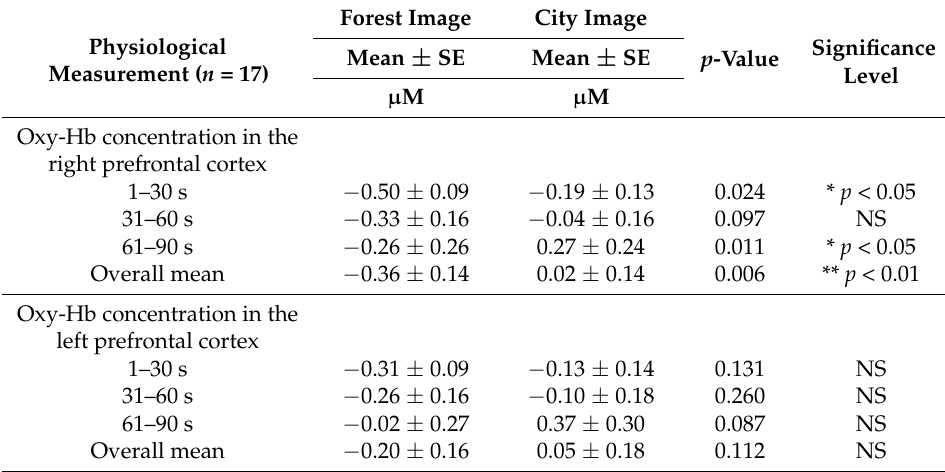
Table 1. Physiological and psychological